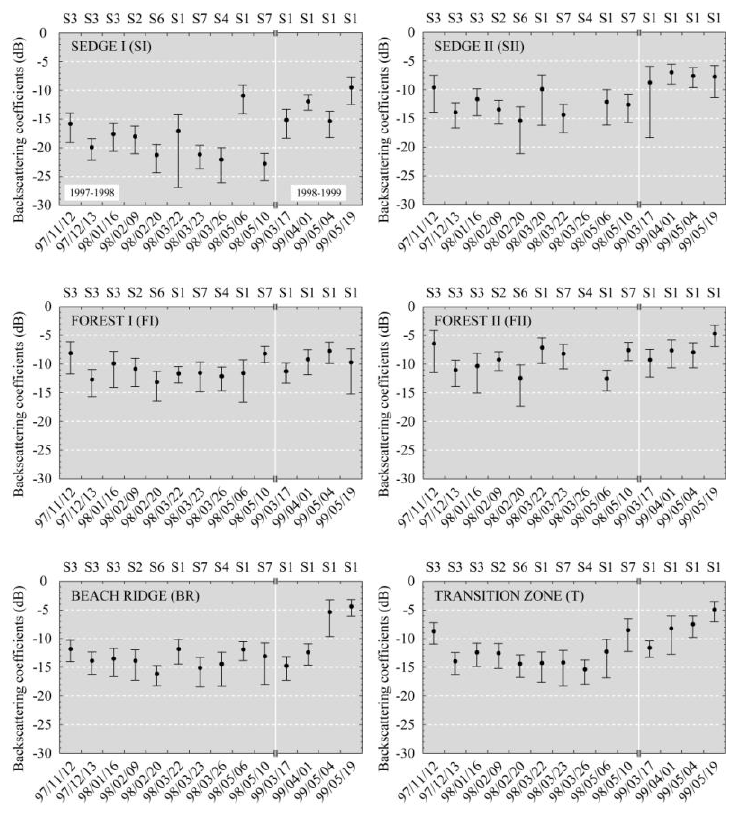
Figure 7. The RADARSAT-1 seasonal backscatter signatures at six sampling sites. Shown are the maximum, mean, and minimum backscattering coefficients for a 5 × 5-pixel subset